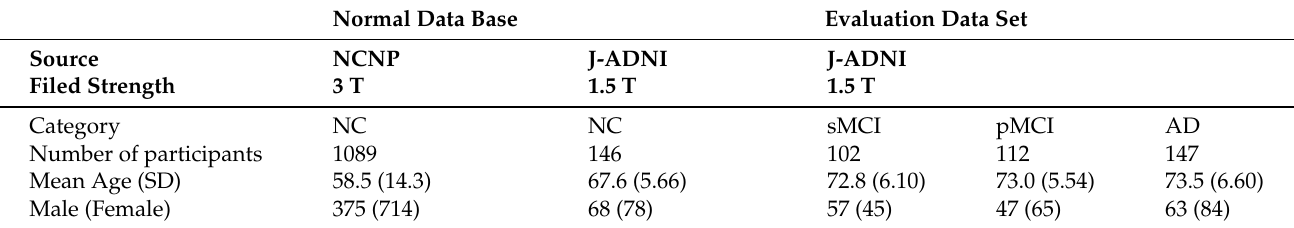
Table 1. Characteristics of the study